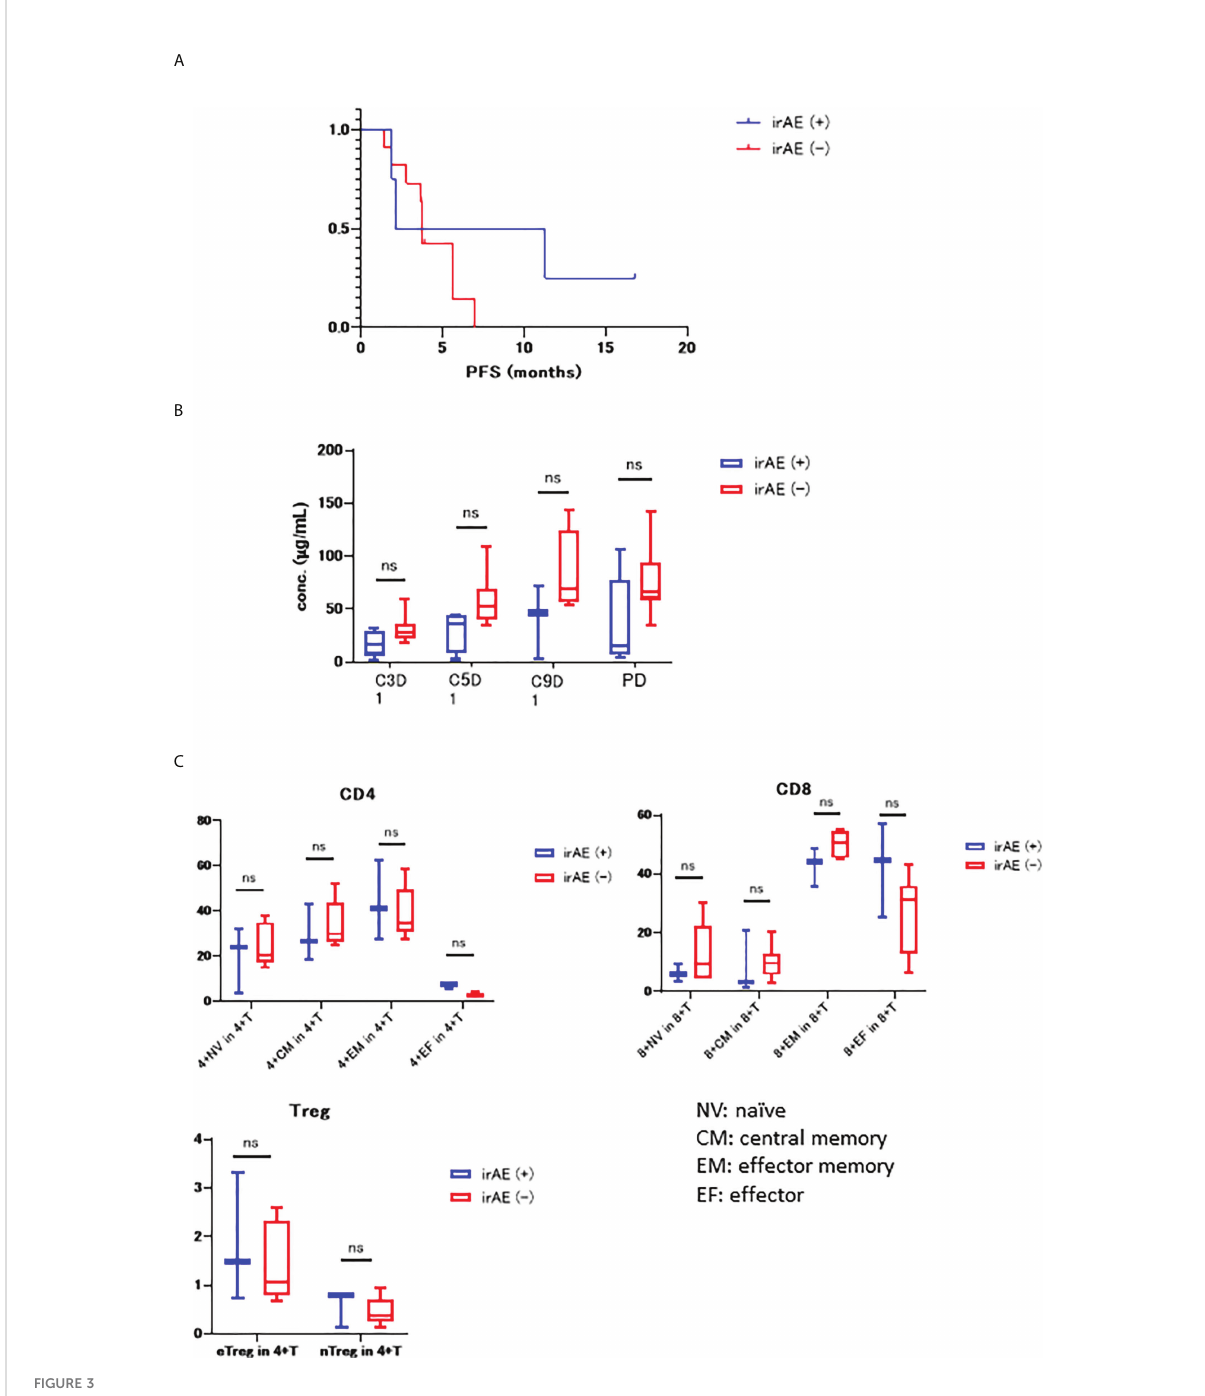
treatment. NV, naïve; CM, central memory; EM, effector memory; EF, effector. “ ns ” stands for not signi fi